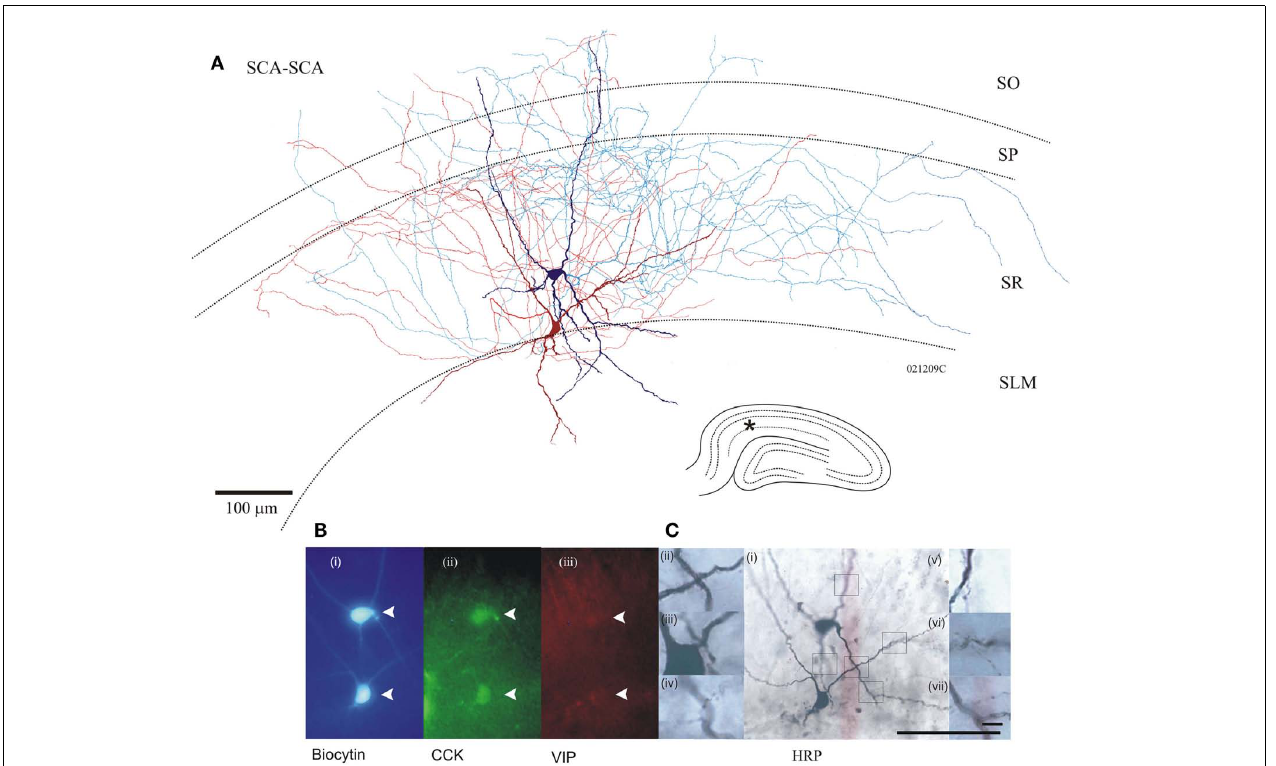
biocytin-filled pair, (ii) green shows positive CCK labeling of biocytin-filled cells (closed arrows); (iii) in red,VIP labeling showing absence of staining in cells of interest. (C) Permanent DAB staining of above cells, with boxes representing location of magnified pictures (i). Close apposition between proximal dendrites of two cells (ii, iii). Putative autapse of dark blue cell (iv, v). Putative synaptic connection, blue to red (vi), and red to blue (vii). Bottom scale bar, 100 μ m [for (i) and Fluorescent images], top Scale bar 10 μ m (for